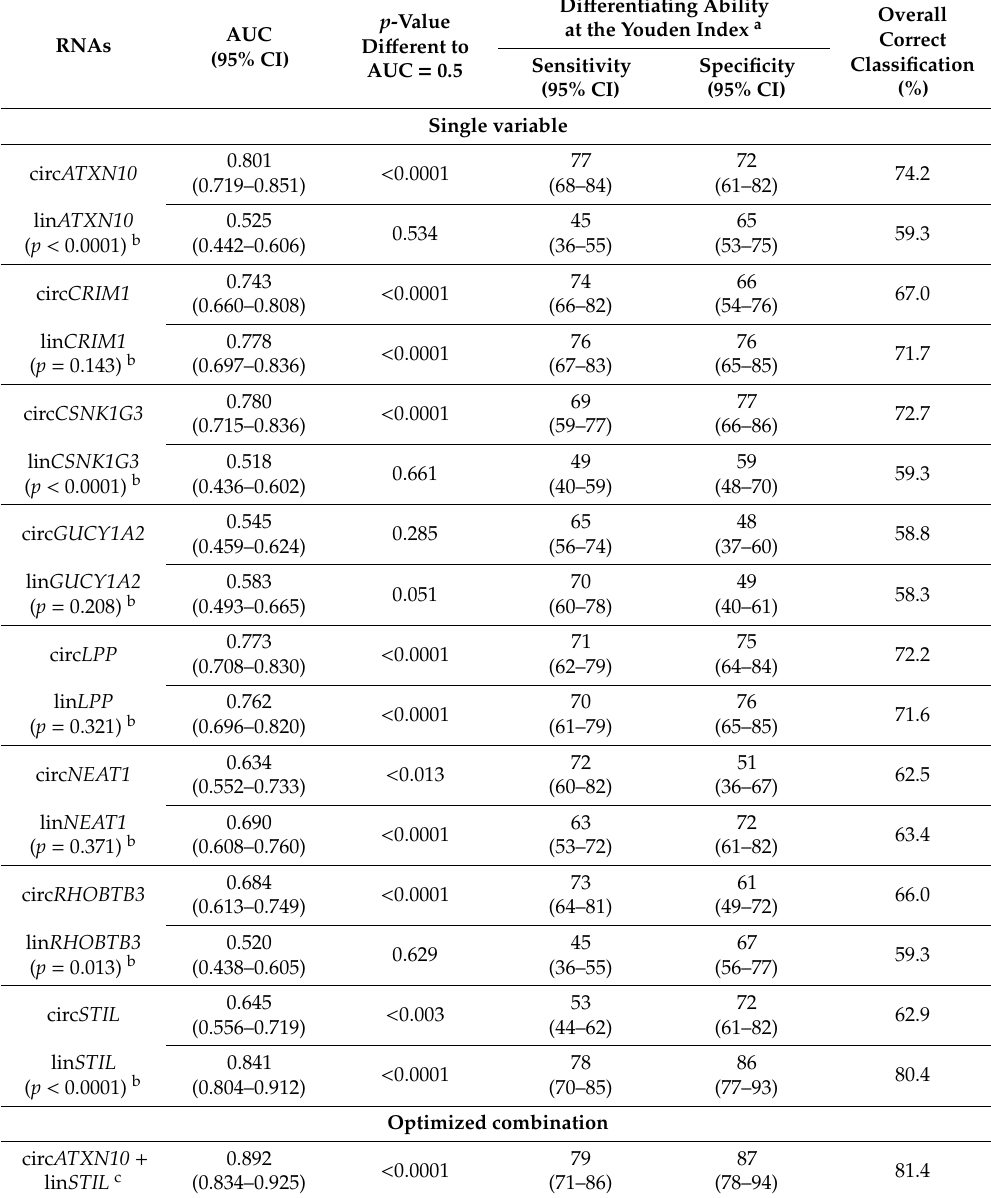
Table 5. Receiver operating characteristic (ROC) curve analyses of circRNAs and their linear transcripts for discrimination between adjacent normal ( n = 79) and malignant ( n = 115) tissue samples from prostate cancer specimens. For circ NEAT1 , only 118 samples could be